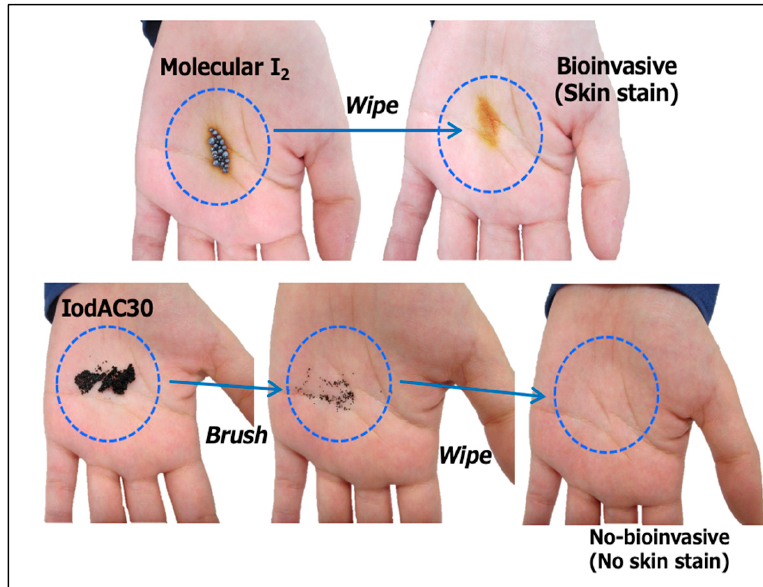
Figure 4. Staining test on human skin, after a one-minute direct contact.